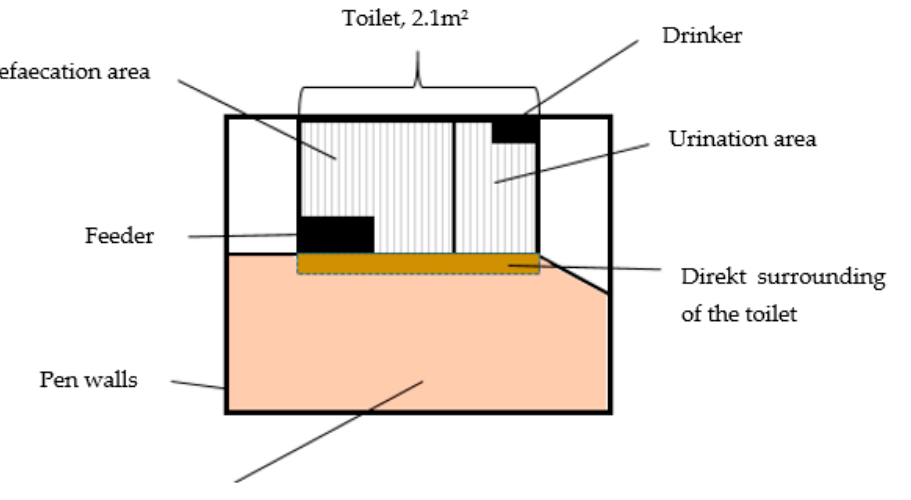
Figure 2. Experimental set ‐ up.